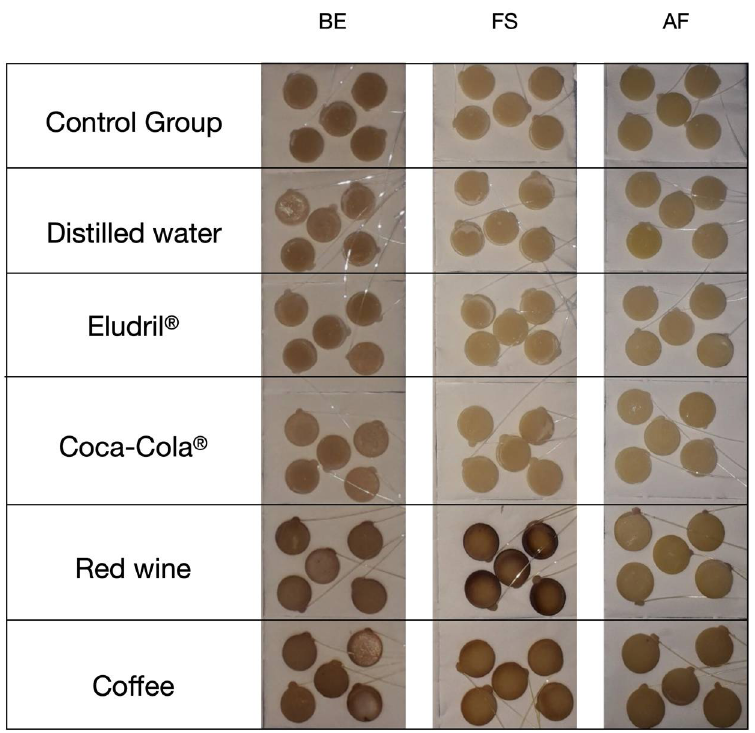
Figure 3. Macro-scale images of the specimens after immersion in the test solutions for 40 h.